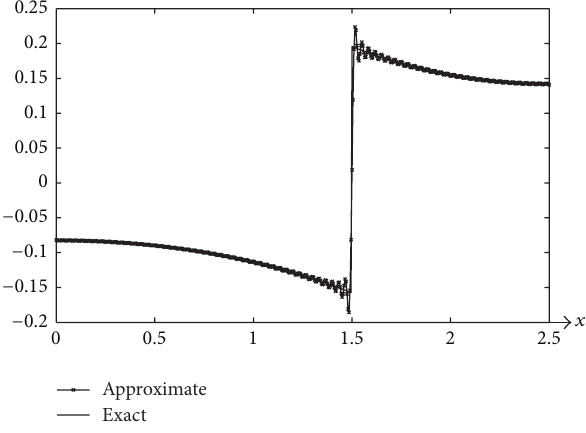
Figure 4: The graphs of ℎ 1 2 and ℎ 1,𝑁 2 for 𝑁 = 150 , 𝑥 0 1 = 2 , 𝑥 0 2 = 3 , and 𝑥 0 3 = 1.5 .